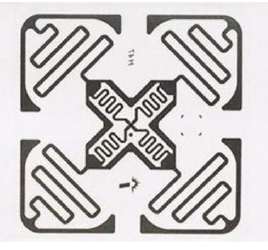
Figure 10. H47UHF Figure 10. H47UHF Tag.